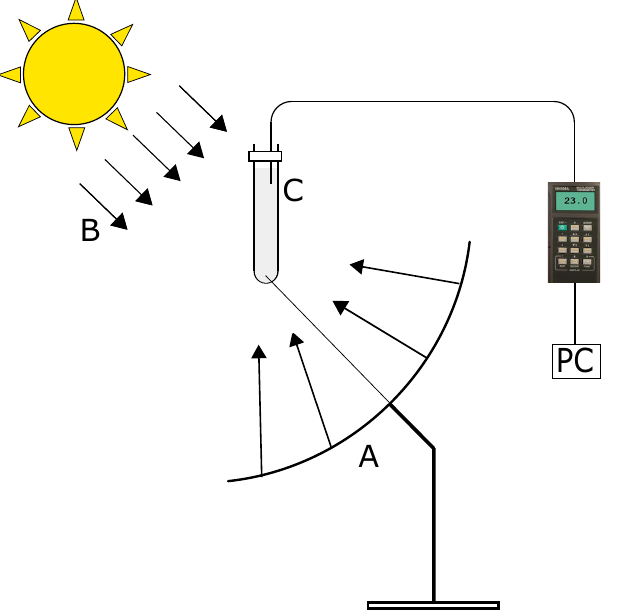
Figure 9. The schematic of the field experimental rig (not to scale). A beaker with a studied liquid is subjected to concentrated solar irradiation. The beaker is located at the focal point of a parabolic collector (the figure was created using Inkscape version